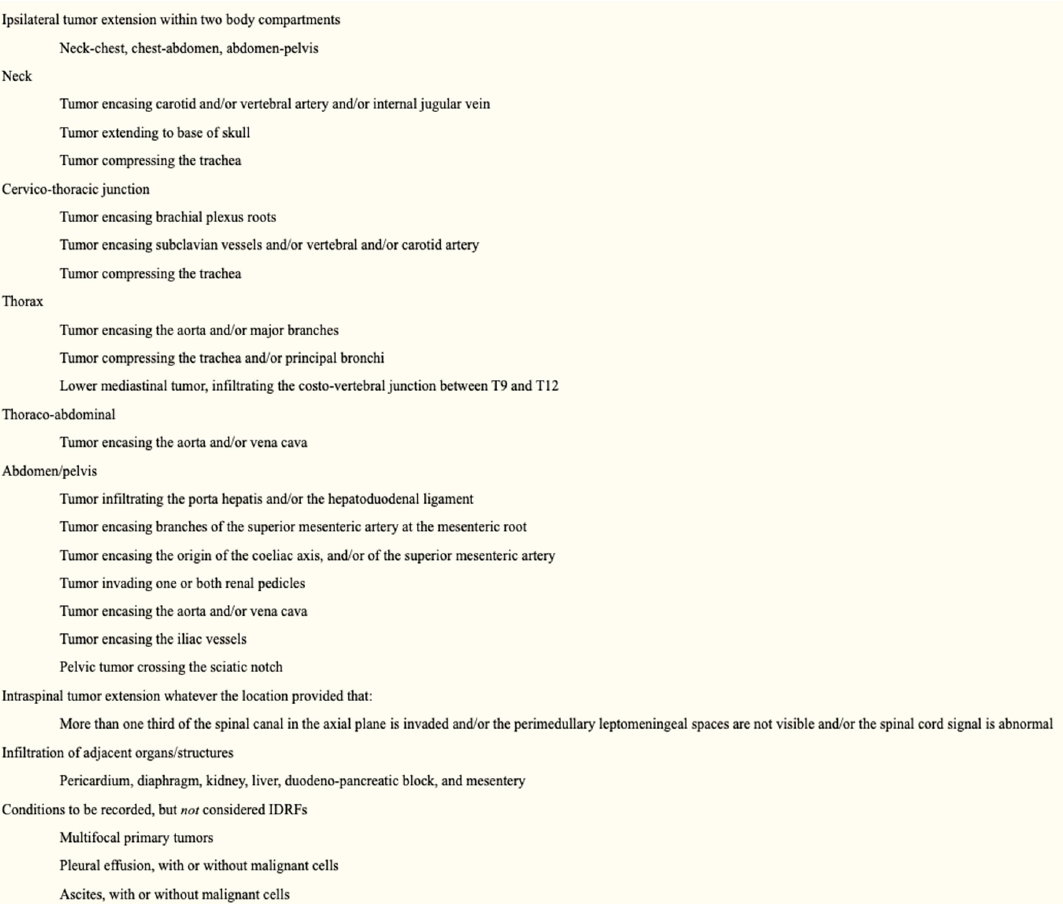
Figure 4. Image-defined risk factors for the INRG classification system [13] (Reprinted with permission from Monclair T. et al.: J. Clin. Oncol. 27(2): 298–303. © 2009 American Society of Clinical Oncology. All rights reserved.).